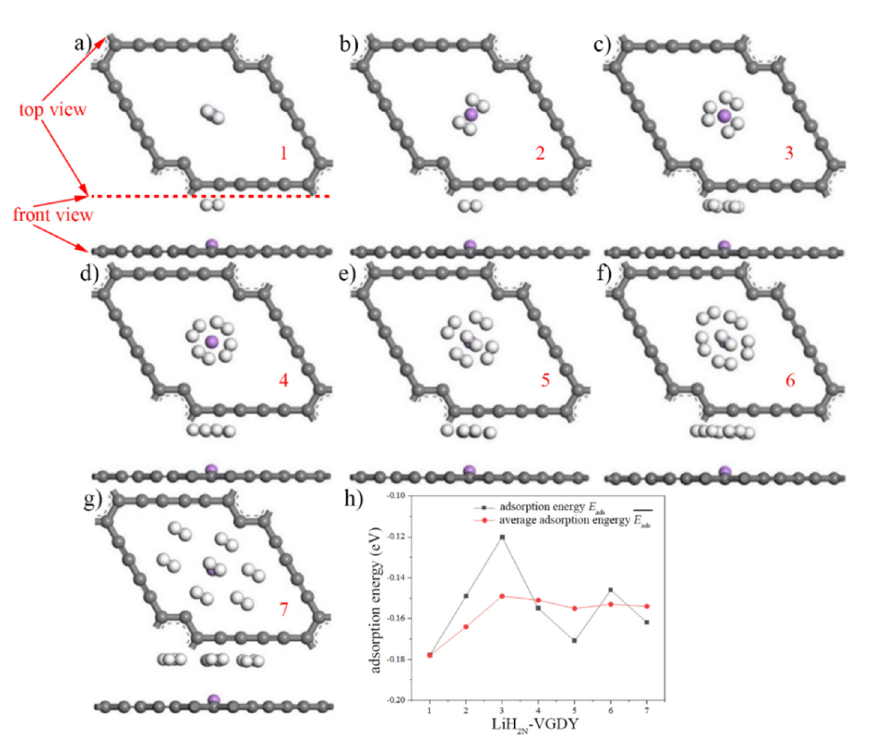
Figure 9. Seven LiH 2N -VGDY models and adsorption energy. (Purple ball is Li atom, white ball is hydrogen molecule, ( a – h ) represent the LiH 2N -VGDY models of hydrogen concentrations with 1, 2, 3, 4, 5, 6 and 7, respectively, ( h ) shows the hydrogen adsorption energy and average adsorption energy of Li-VGDY).